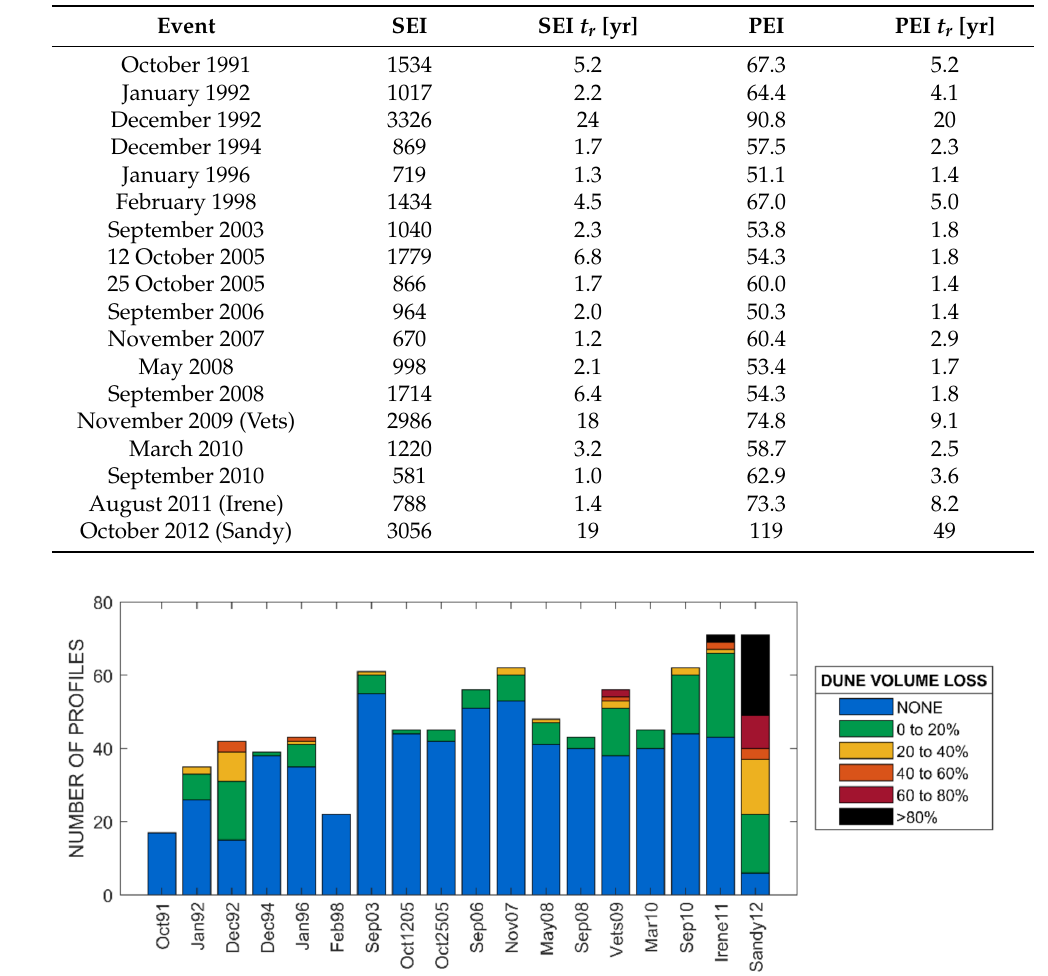
Table 2. Average SEI and PEI values, and associated return periods ( t r ), for eighteen historical storms in New Jersey. Storm data from [20]. Return periods are based on frequency of occurrence curves by [49].